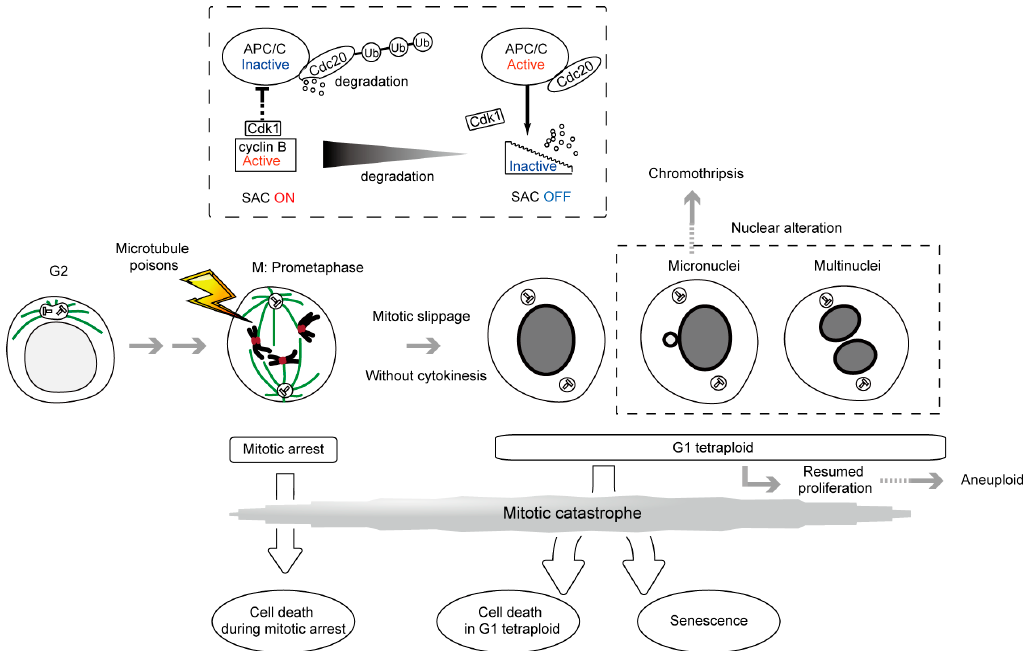
Figure 1. Mitotic catastrophe caused by microtubule poisons. Mitotic catastrophe is a bona fide intrinsic oncosuppressive mechanism that senses mitotic failure and responds by driving a cell towards an irreversible antiproliferative fate of death or senescence [3,4]. Irreversible antiproliferative processes occur during the mitotic phase in diploid cells and the tetraploid state generated after mitotic slippage. The processes governing mitotic arrest and mitotic slippage are described, with the levels of the mitotic cyclin, cyclin B1, being indicated. Nuclear alterations characterizing the mitotic catastrophe are also described. Clustered micronuclei, the third nuclear alteration, are described in Figure 4, but not in Figure 1. In the case of cancer cells whose chromosome number is frequently abnormal, diploid and tetraploid denote the cells with the original number of chromosomes before the treatment of microtubule poisons and with twice the number of chromosomes, respectively.